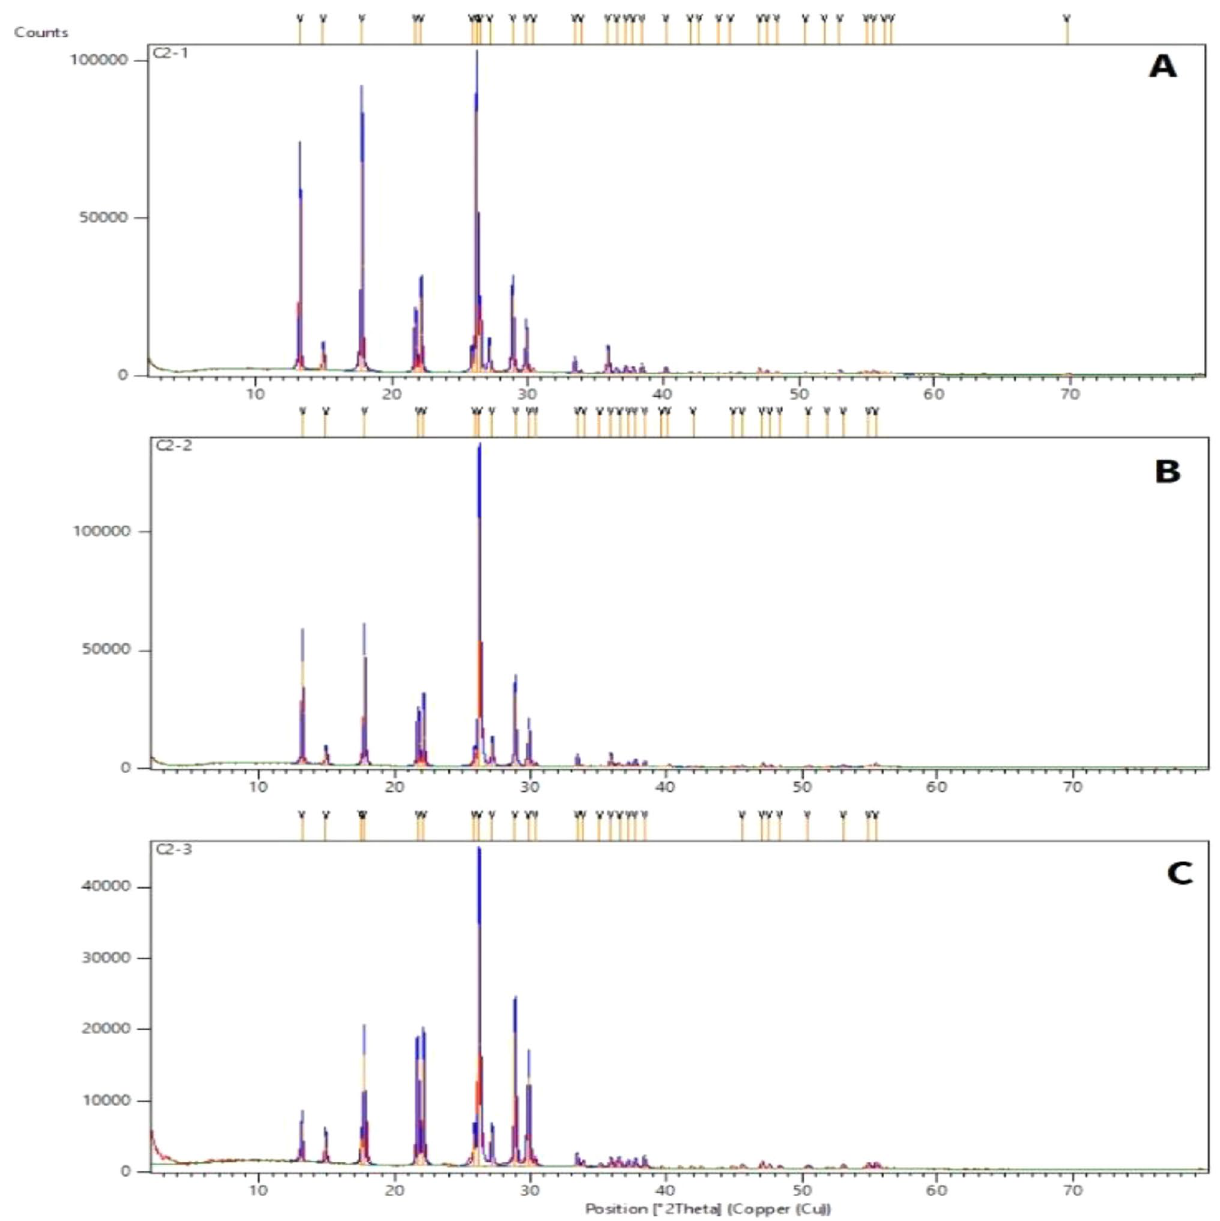
Figure 2. XRD patterns of the melamine ( A ), the Melamine@PrBr ( B ), and the nano-ordered Melamine@TMG ( 1 , C